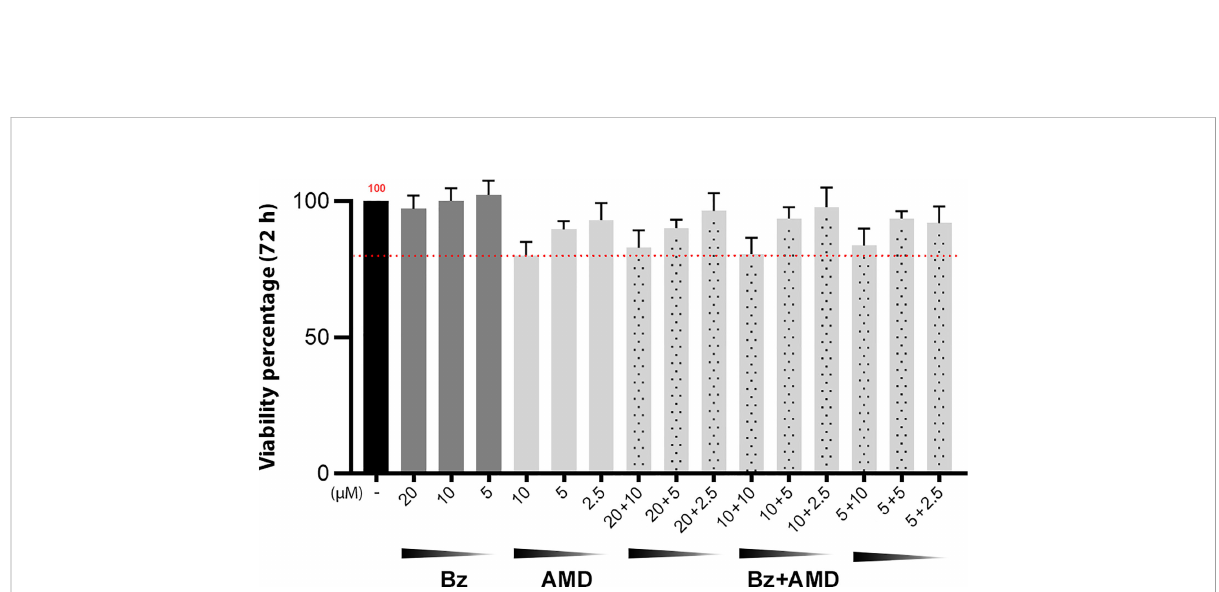
FIGURE 4 Viability of uninfected and treated HCs after 72 h of treatment with Bz, AMD or their combination, demonstrating the non-cytotoxicity of all treatment regimens. The black bar corresponds to the control condition (untreated); dark gray bars correspond to Bz and light gray bars to AMD, and the dotted bars correspond to the combined treatments. The red dotted line highlights 80% viability. (One-way ANOVA followed by Tukey ’ s post-hoc test).